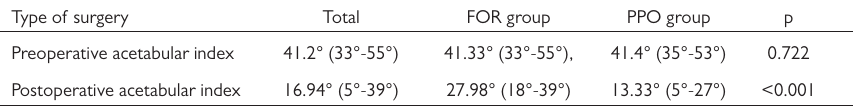
Table 2. Comparison of the FOR group and the PPO group according to pre- and postoperative acetabular indices Type of surgery